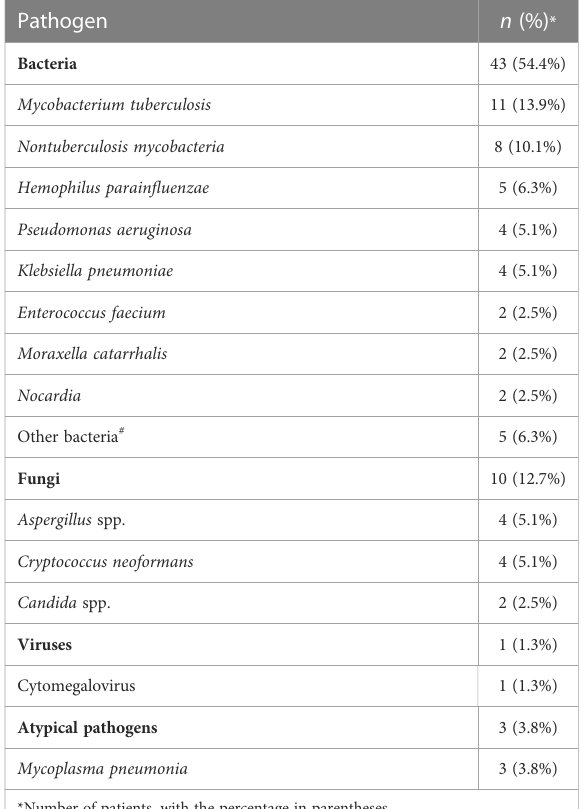
TABLE 2 Distribution of pathogens identi fi ed in patients with infectious pulmonary